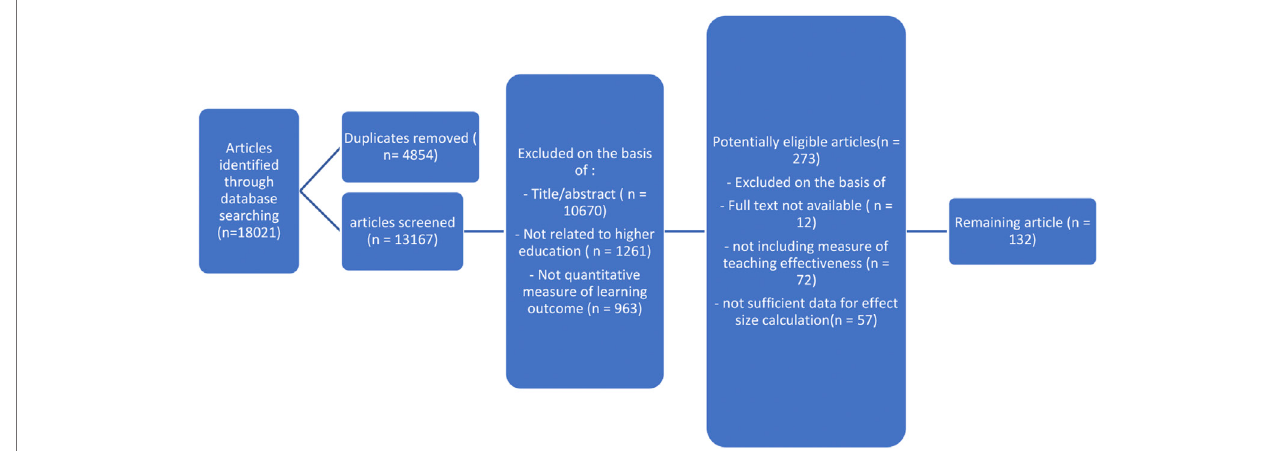
FIGURE 1 | Selection of